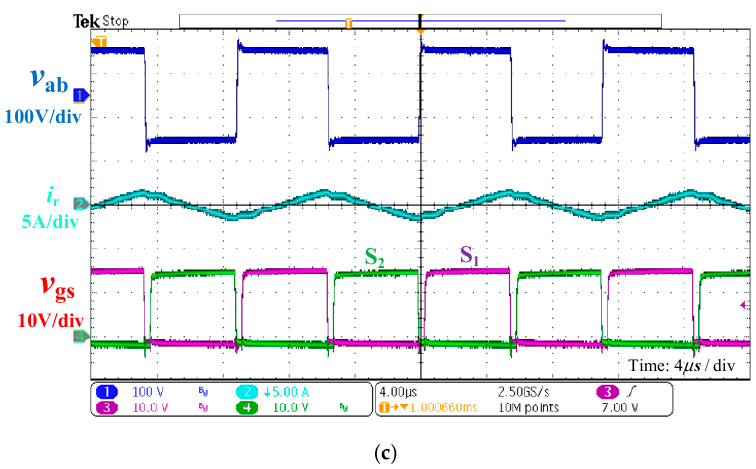
Figure 14. Experimental waveforms under different loads ( f = f r ): ( a ) full load; ( b ) 1% rated load; ( c ) no load.